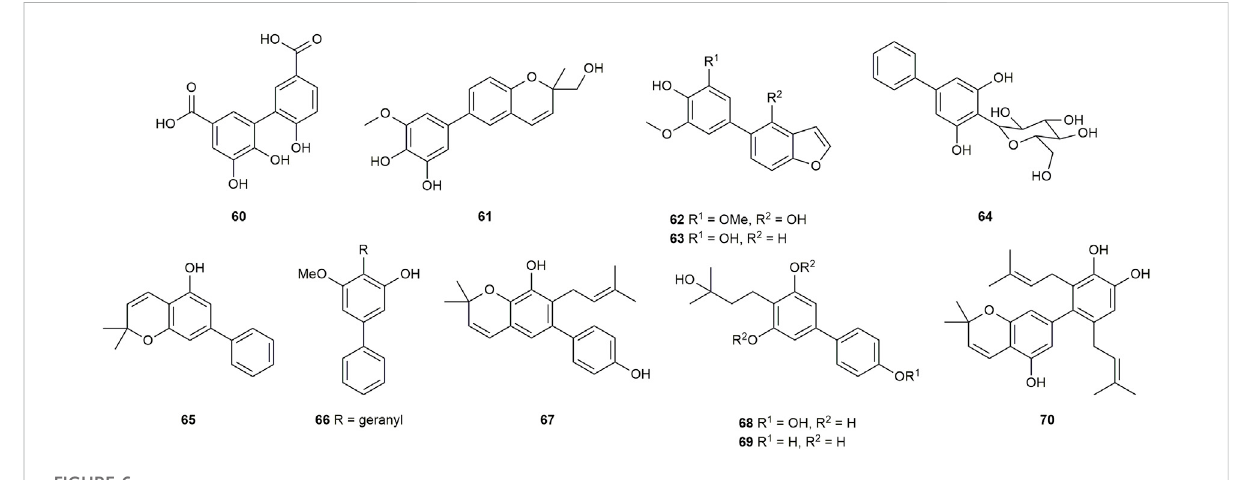
FIGURE 6 Structures of biphenyls 60 – 70